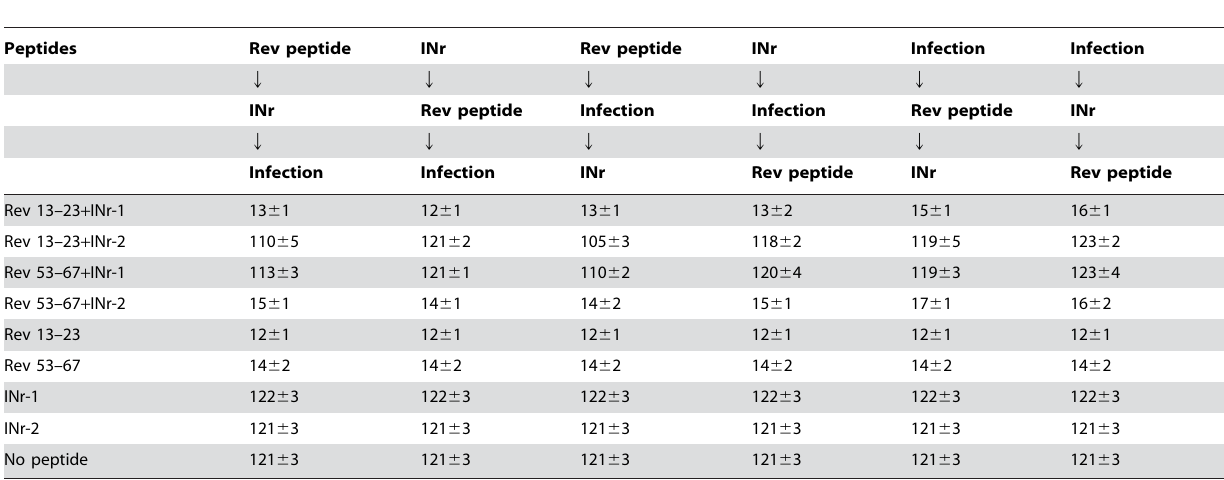
Table 3. Inhibition of HIV-1 infection by the Rev-derived peptides and its abrogation by the INr peptides are not affected by order of addition: a summary of the results described in Figure 5.